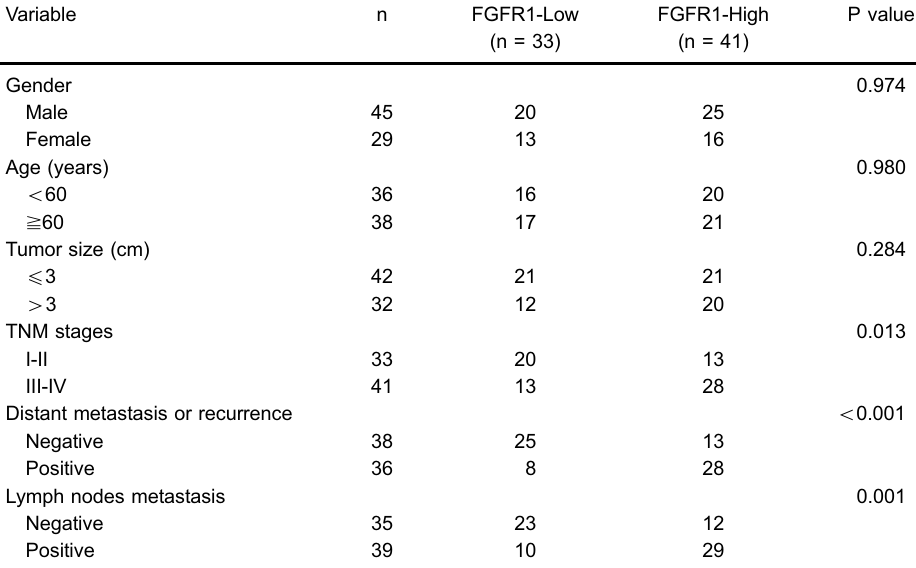
Table 1. Correlation between clinicopathological factors and fi broblast growth factor receptor 1 (FGFR1) expression levels in gastric cancer patients.